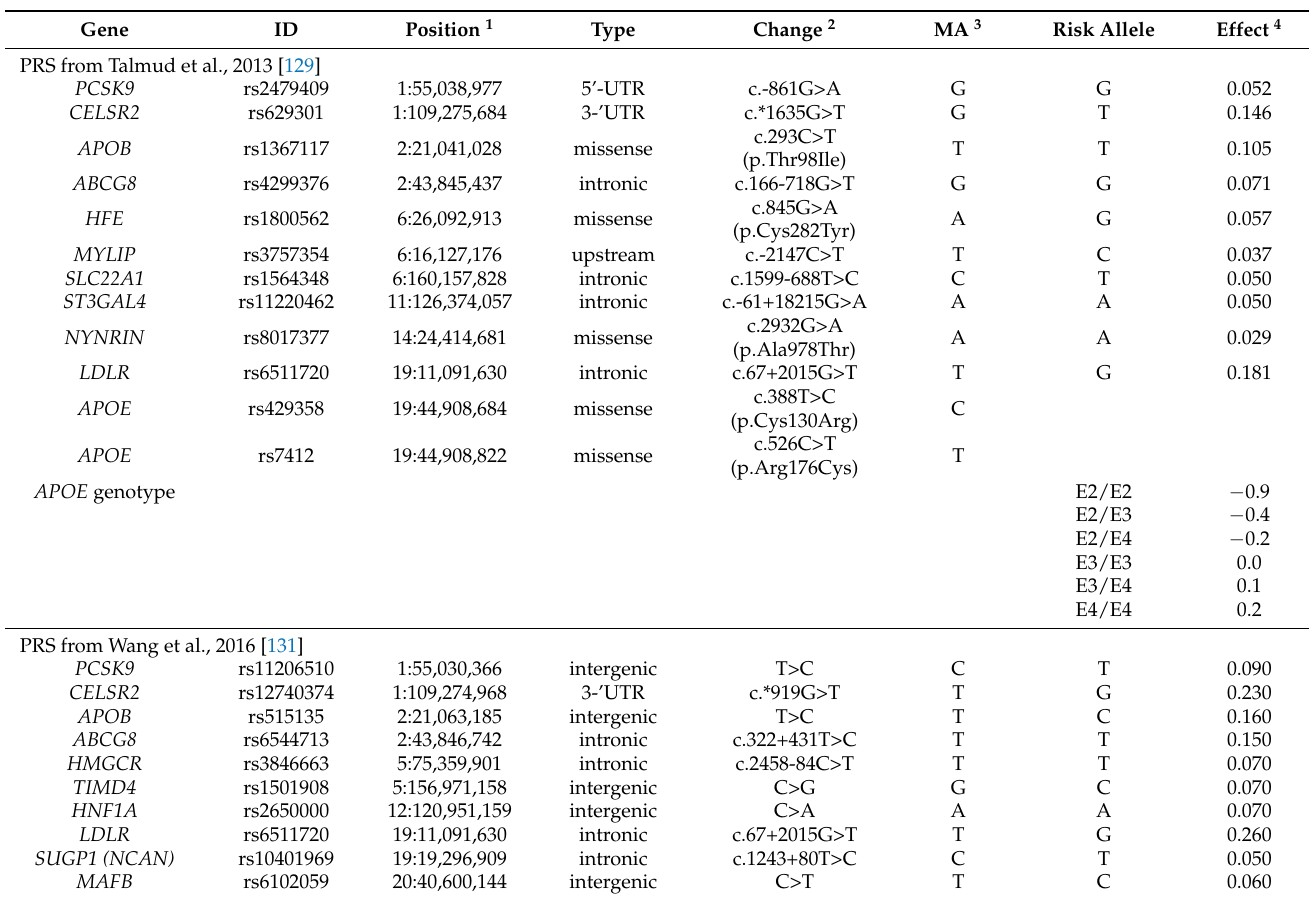
Table 2. SNVs associated with LDL-c plasma level used in two gene score